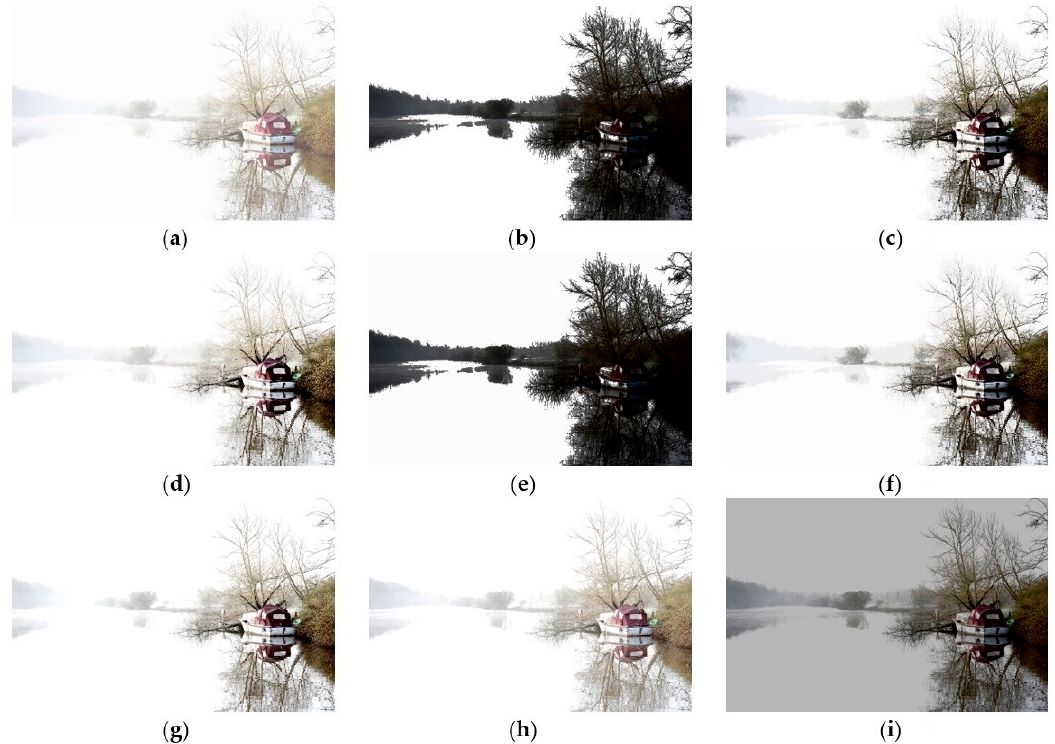
Figure 10. Results of different methods for the image Boat [28] (image size: 900 × 600 pixels): ( a ) Original image; ( b ) HE; ( c ) BBHE; ( d ) RMSHE (r = 2); ( e ) DSIHE; ( f ) RSIHE (r = 2); ( g ) DQHEPL; ( h ) VCEA; and ( i ) CegaHE.